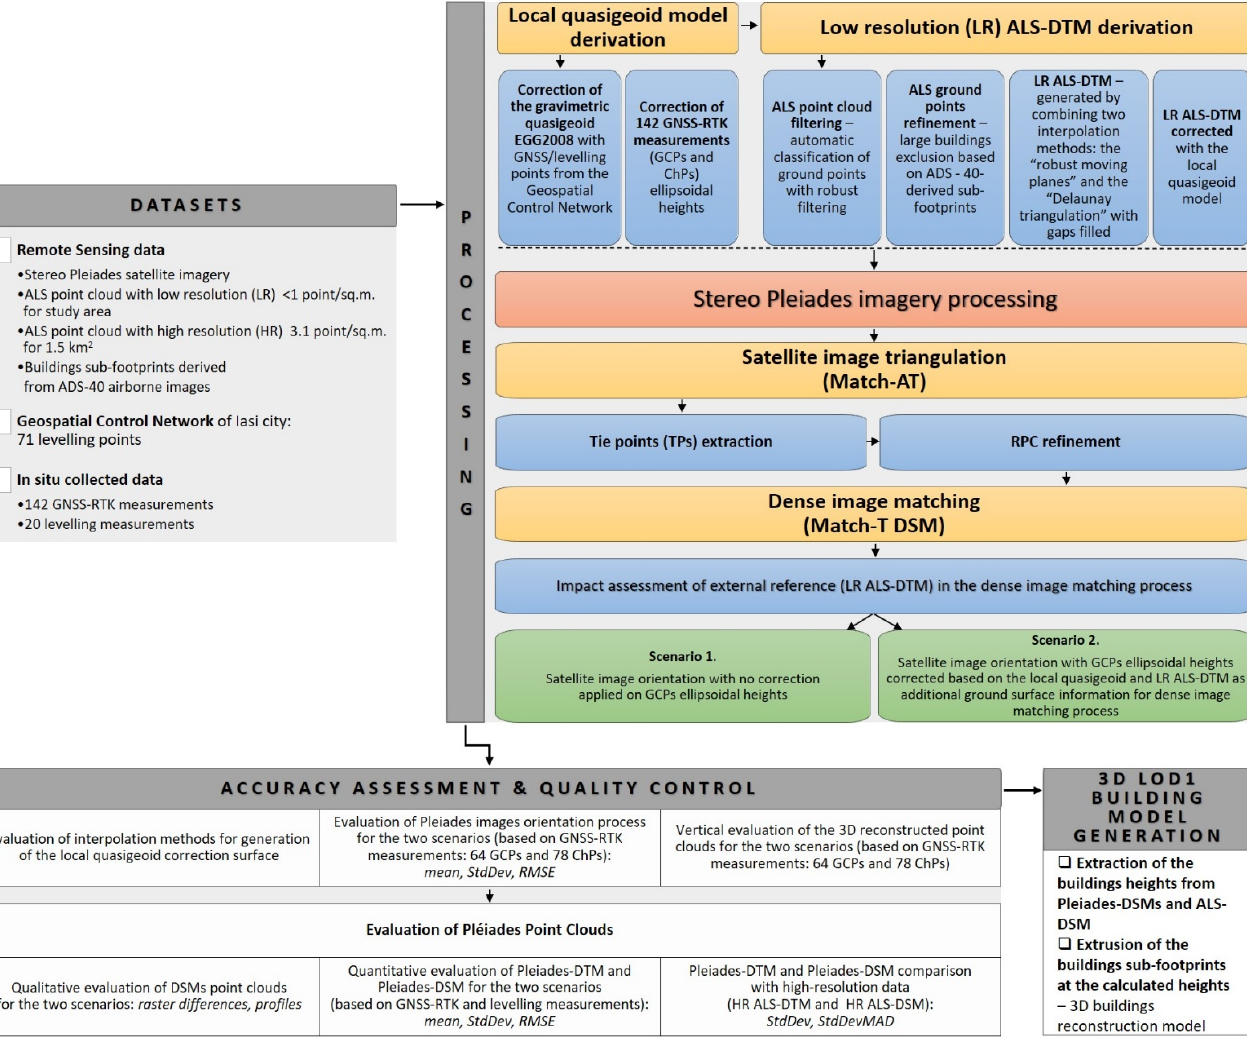
Figure 2. Flow chart of research methodology.